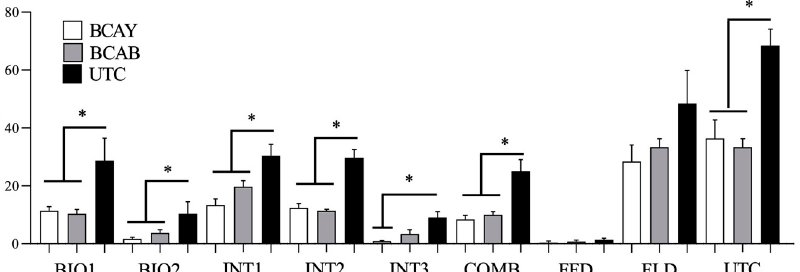
Figure 4. Postharvest brown rot incidence on plum fruits that were sprayed, immediately after harvest, with cell suspensions of either the BCA Papiliotrema terrestris PT22AV (BCAY) or the commercial biofungicide Serenade Max ® based on Bacillus subtilis strain QST 713 (BCAB). The disease incidence was assessed after 15 days of storage at room temperature. For each treatment, the efficacy was compared with the respective postharvest untreated control (UTC). The columns marked with an asterisk are significantly different according to Uncorrected Fisher’s LSD comparison test ( p < 0.05).